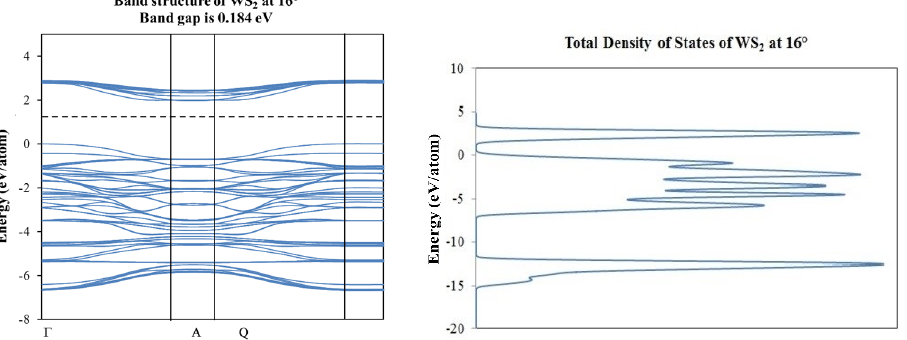
Figure 7. Band structure and partial total density of states plots corresponding to 0° ( top ) and 16° ( bottom ) of rotation in WS 2 molecular structure.